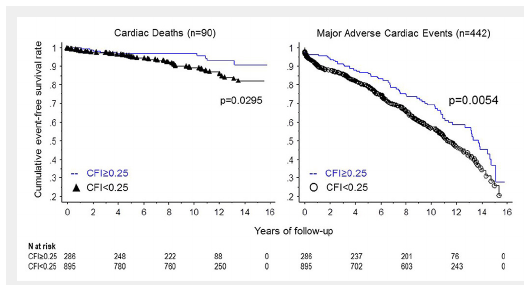
Cumulative survival rates in patients with low and with high collateral flow index (CFI). (Data from Seiler C, et al. Prognostic relevance of coronary collateral function: confounded or causal relationship? Heart. 2013;99(19):1408-14 [5], with permission from BMJ Publication Group Ltd.)